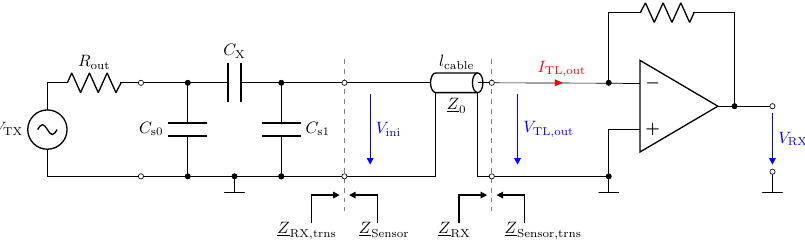
Figure 10. Low-impedance receiver circuit connected to a capacitive Π -network by means of a trans- mission line with length l cable and impedance Z 0 = 50 Ω . R out = 50 Ω , R f = 500 Ω , C X = 1pF, C s0 = C s1 =